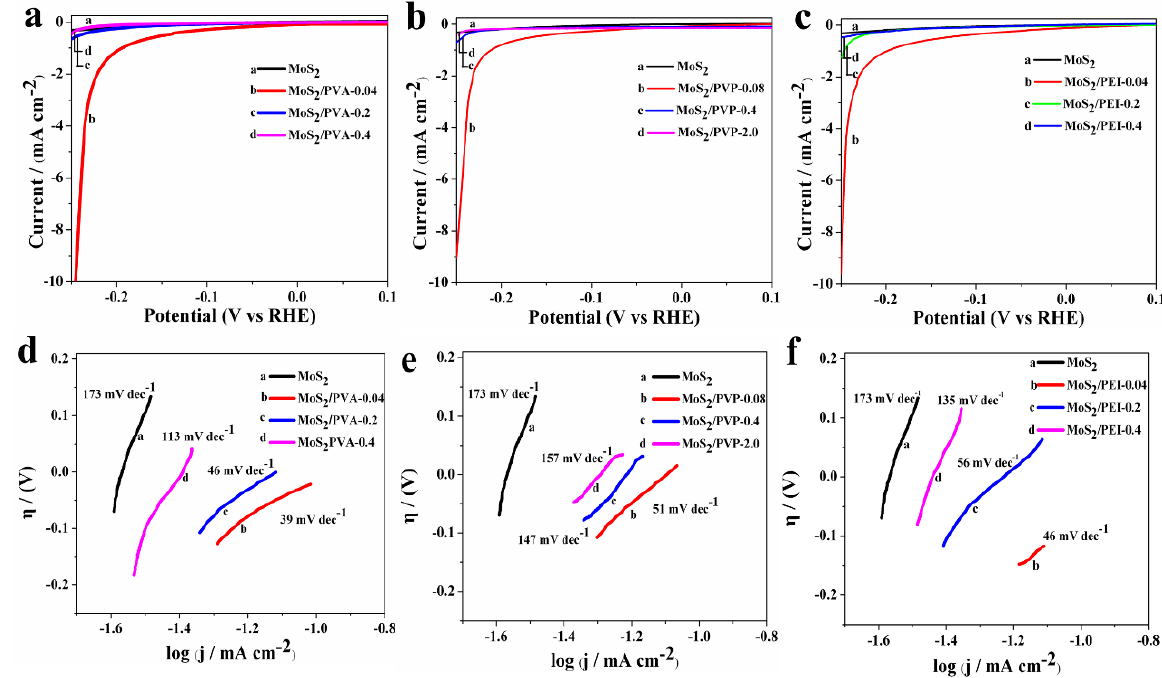
Figure 7. Polarization curves ( a – c ) and corresponding Tafel plots ( d – f ) of the MoS 2 /PVA, MoS 2 /PVP, MoS 2 /PEI